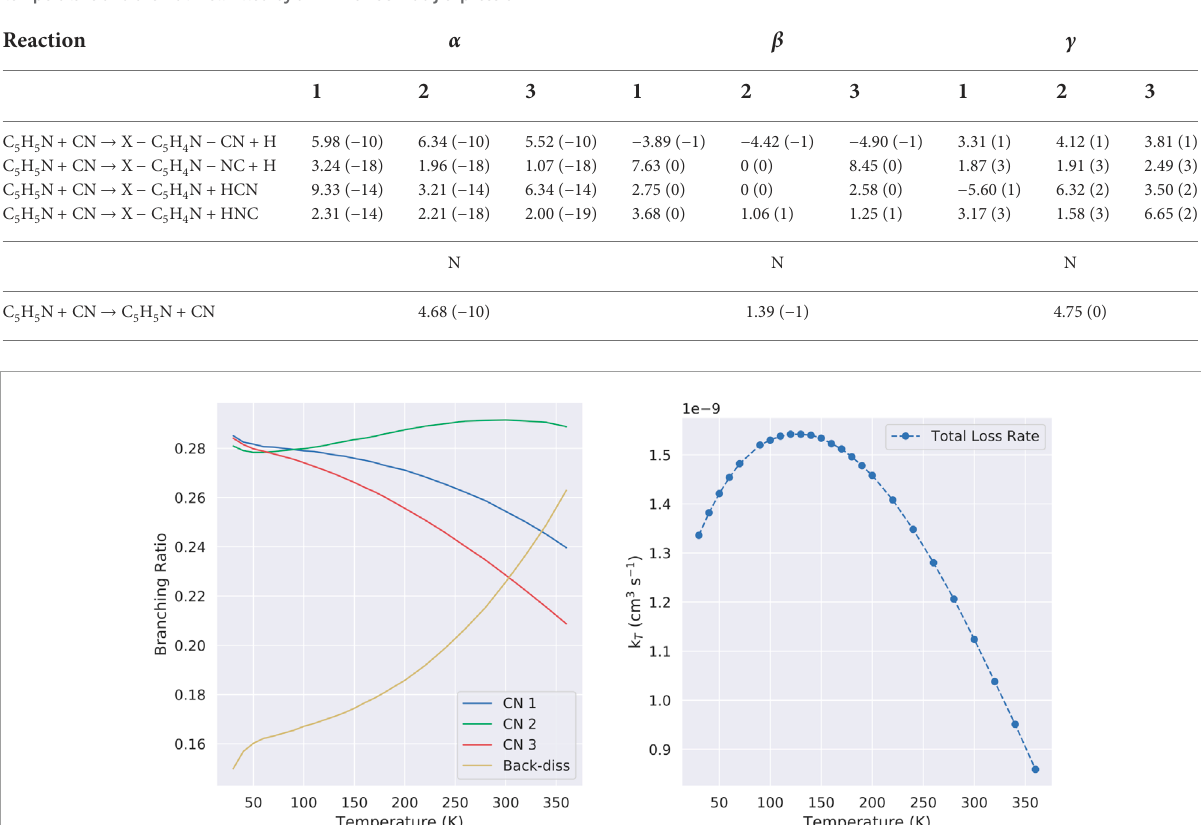
FIGURE 7 (Left) Branching ratios for the main reaction channels considered in this work (Right) Total loss rate constant for the title reaction.